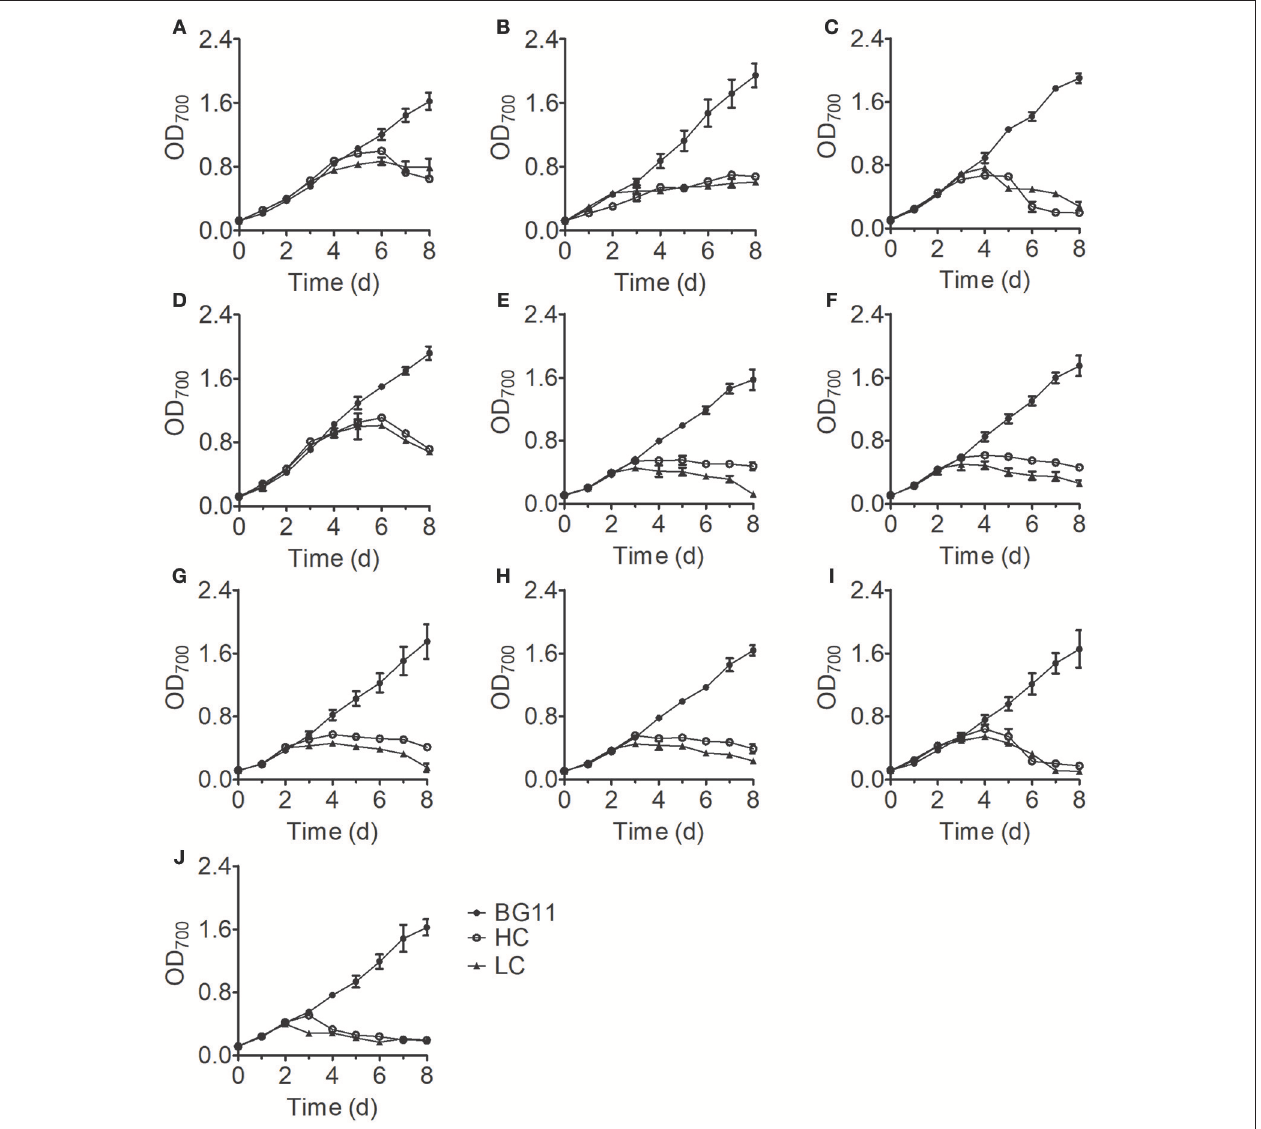
FIGURE 1 | Growth curves of 10 Chlorella strains cultivated in BG11 medium (BG11) and in N-deficient BG11 medium supplemented with 0.5g L − 1 NH 4 Cl (HC) or 0.05g L − 1 NH 4 Cl (LC). (A–J) Represent Chlorella strain FACHB-1, FACHB-1216, FACHB-1535, FACHB-1563, W1, W2, W3, W4, W5, and W6, respectively. For all figures, the data points represent the means of three replicate experiments for each independent culture, with the SD of the